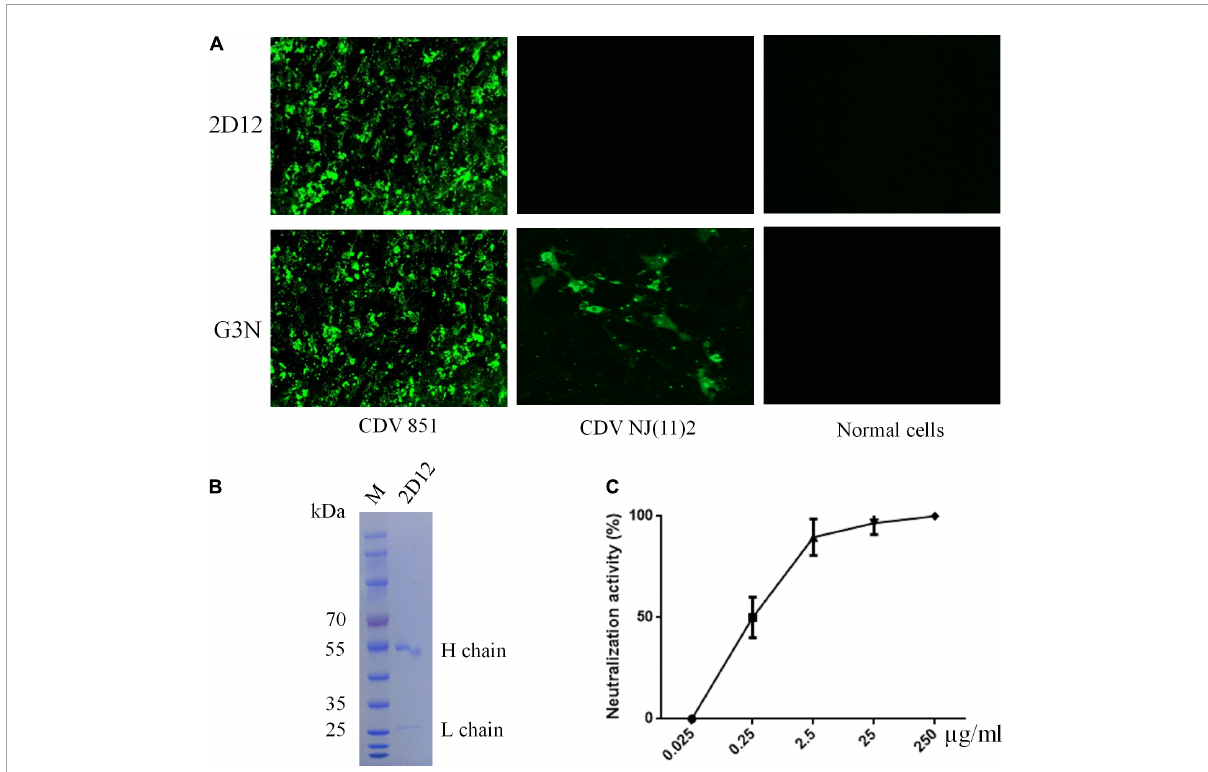
FIGURE1 Characterization of mAb 2D12. (A) Identification of the reactivity of mAb 2D12 with CDV 851 strain in Vero and CDV NJ(11)2 in Vero-SLAM cells by immunofluorescence assay (IFA). The Vero cells were infected with CDV 851 strain, while Vero-SLAM cells were infected with CDV NJ(11)2 strain, which were inculated with mAbs 2D12 or G3N. (B) The purification of mAb 2D12. The mouse ascites of mAb 2D12 were purified by affinity chromatography using HiTrap TM Protein G and analyzed by SDS-PAGE. (C) Virus neutralization assay. The CDV 851 strain was incubated with the indicated dilution of purified mAb 2D12, the virus-antibody mixture was inoculated onto Vero cells, the cytopathic effect (CPE) was observed and the VN antibody titers expressed as the reciprocal of the highest plasma dilution giving 50% protection. Means ± S.D. of data from three independent experiments performed in triplicates are